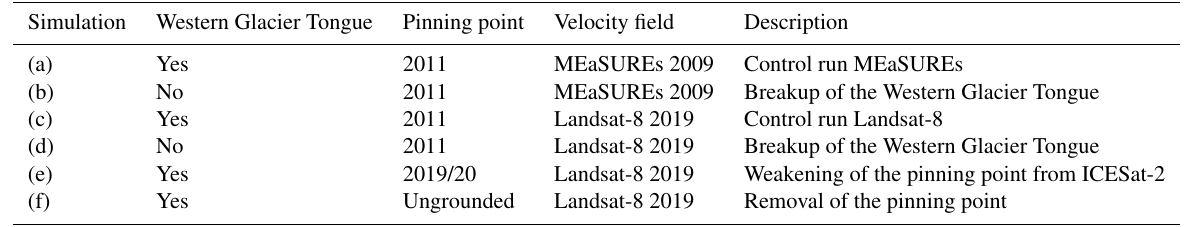
Table 1. Setup of the perturbation experiments in